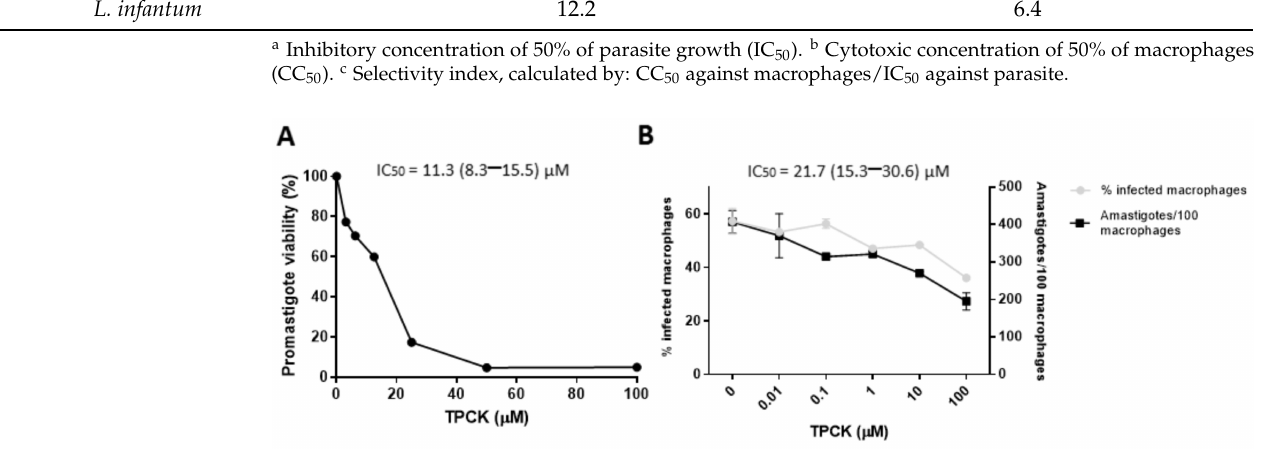
Figure 3. In vitro TPCK effects against L. infantum . ( A ) Inhibitory TPCK effect on L. infantum promastigotes. Promastigotes were distributed in 96-well plates, incubated with TPCK at 26 ◦ C for 72 h, and cell viability was determined by the MTT assay. ( B ) Inhibitory TPCK effect on intracellular L. infantum amastigotes. These forms were treated with different TPCK concentrations for 72 h and subsequently counted. The graph shows the total number of amastigotes and the percentage of infected macrophages. Graphs were plotted using GraphPad Prism 8 (GraphPad Software, Inc., La Jolla, CA, USA). Results are expressed as means ± standard error. IC 50 and CC 50 values were obtained by non-linear regressions using Graphpad Prism 8 software. Graphs are representative of three independent